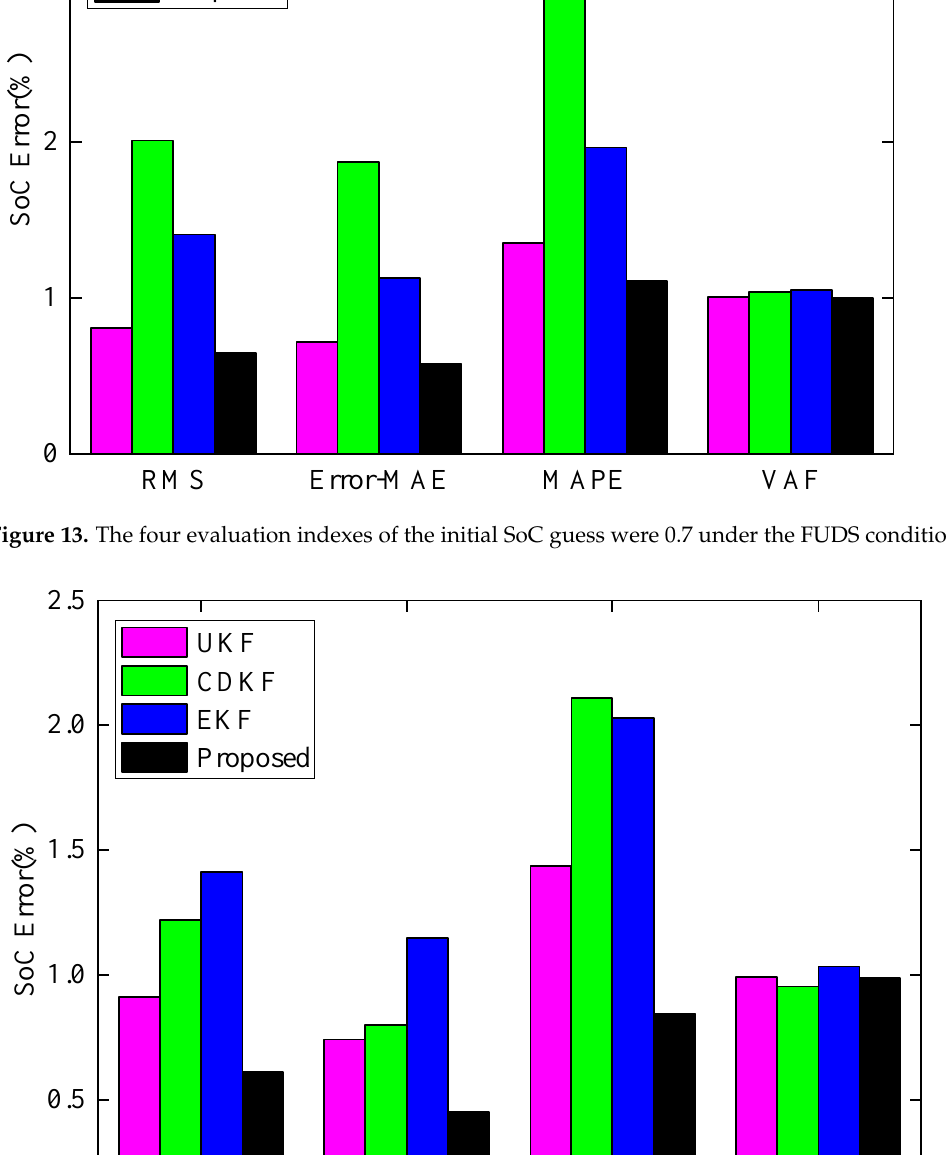
Figure 12. The initial SoC guess was 0.9 under the US06 condition.